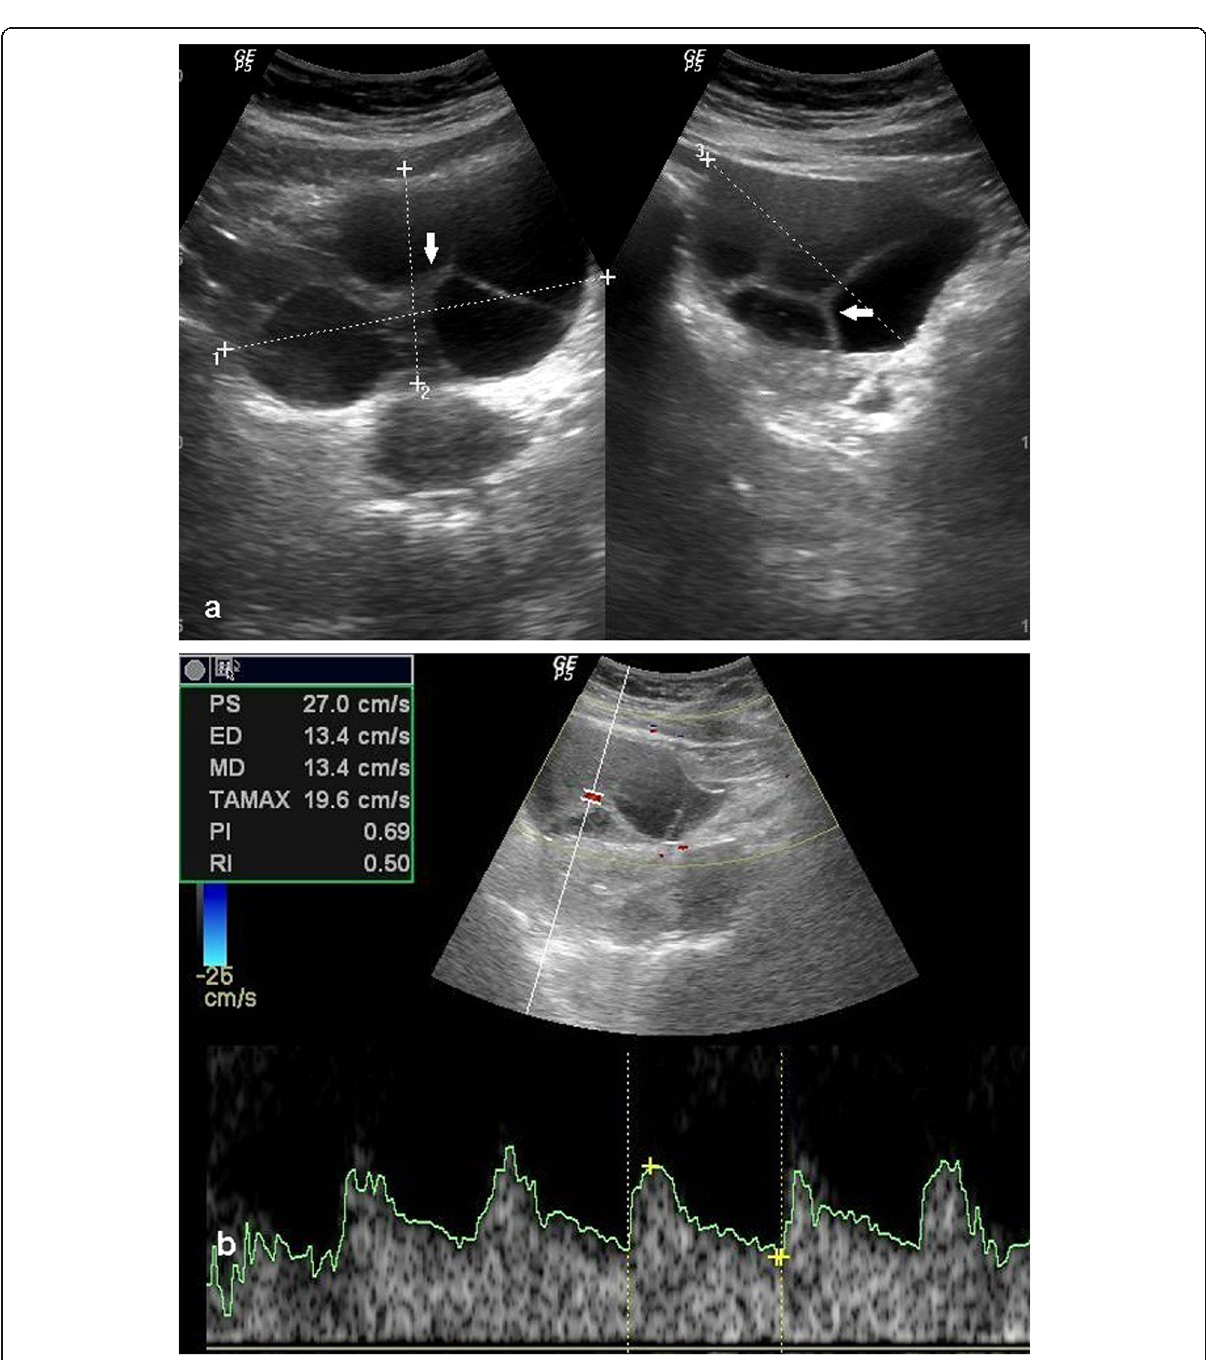
Fig. 4 A 48-year-old woman with accidentally discovered right ovarian lesion on ultrasound. a Transabdominal ultrasound shows cystic lesion with multiple thick septa (white arrow); it measures 10 cm × 7 cm × 6 cm, b while spectral Doppler ultrasound detects blood flow within the central portion of the septa and shows 0.5 RI and 0.6 PI. The histopathological examination after laparoscopy revealed serous